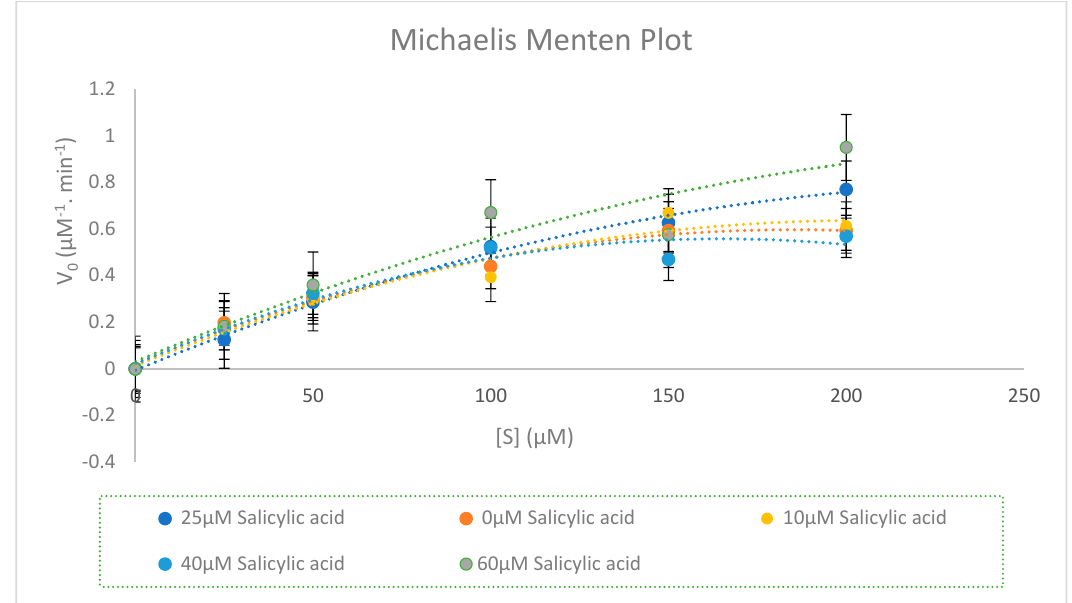
Figure 5. Representative Michaelis–Menten plot for the inhibition of CYP2E1-catalysed chlorzoxazone 6-hydroxylation (chlorzoxazone (25, 50, 100, 150, and 200 µM)) by 0, 10, 25, 40, and 60 µM salicylic acid. The curves were fitted with a polynomial function of order 2. Each point represents the average of three determinations.